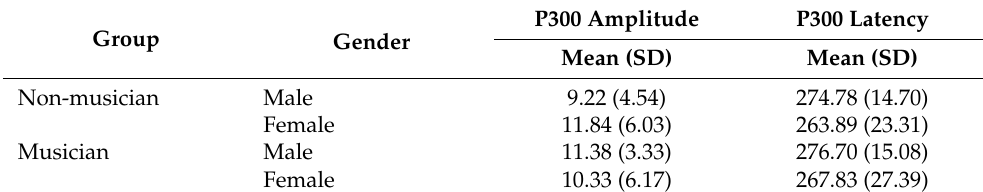
Table 3. The average amplitude and latency of P300. The standard deviations are listed in parentheses.